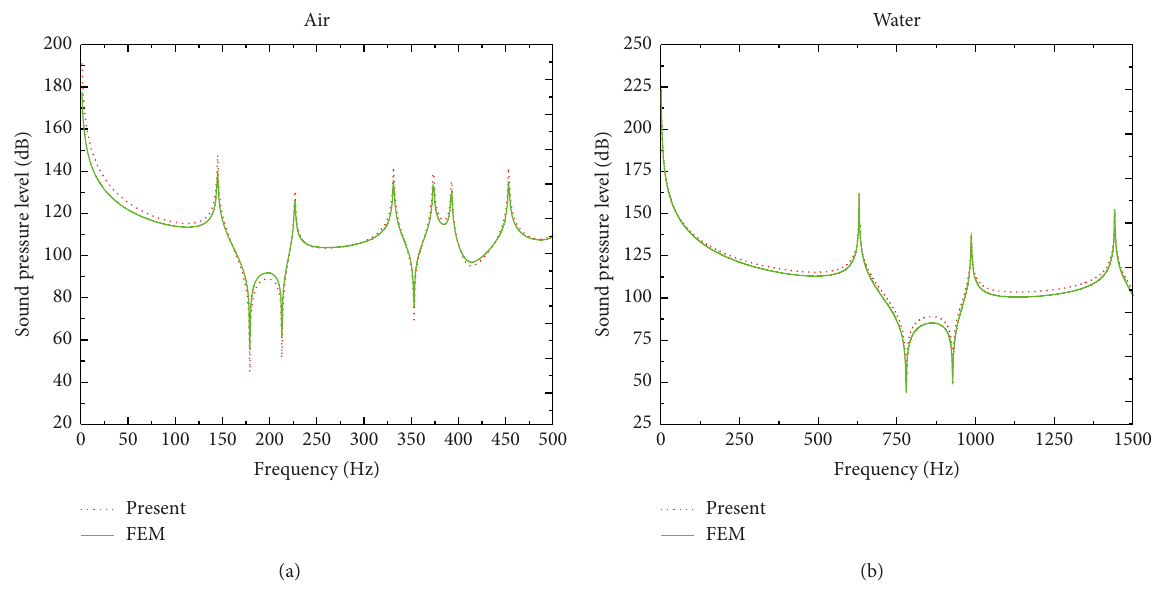
Figure 12: Acoustic pressure response of the quadrangular prism acoustic cavity with impedance walls under the unit point sound source